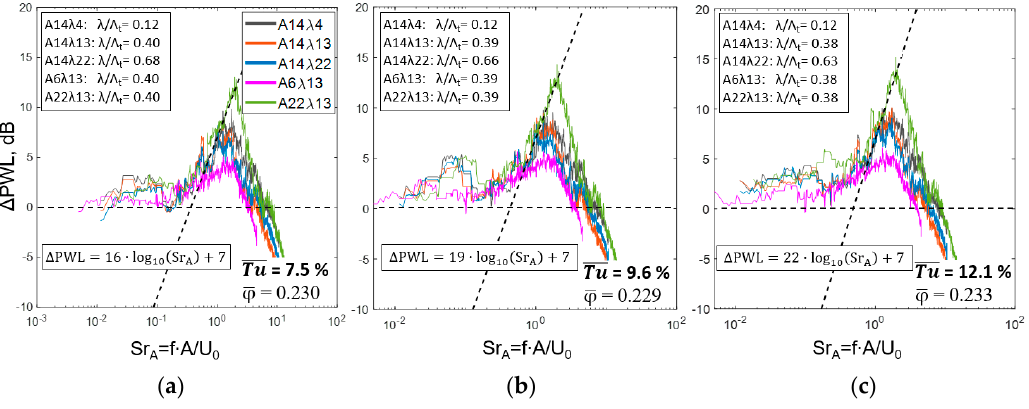
Figure 10. Spectral sound power level reduction Δ PWL of the tested rotors at maximum flow coefficient φ and varying Tu . 20th-order median-filtered signals of broadband components only. Additional indication of the λ / Λ t -ratio. ( a ) Tu = 7.5%; ( b ) Tu = 9.6%; ( c ) Tu = 12.1%.